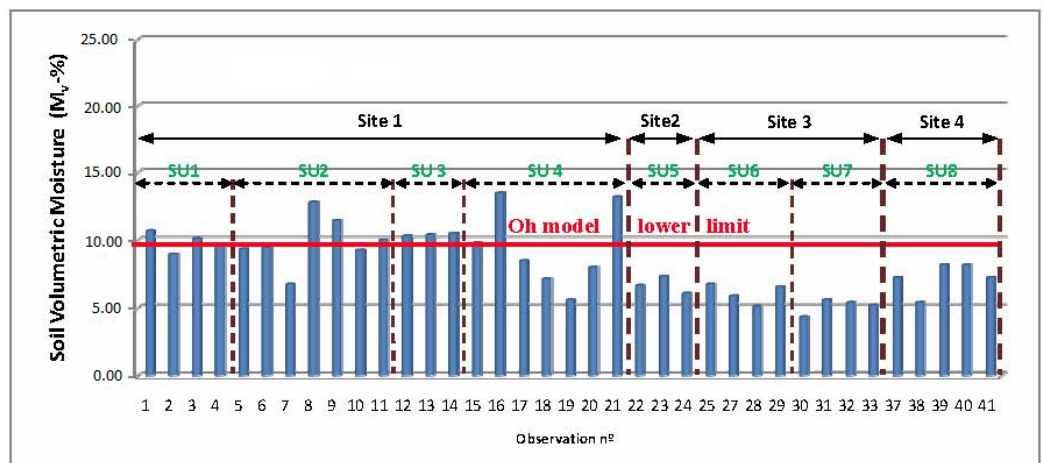
Figure 7. Soil volumetric moisture values for each sampled location.